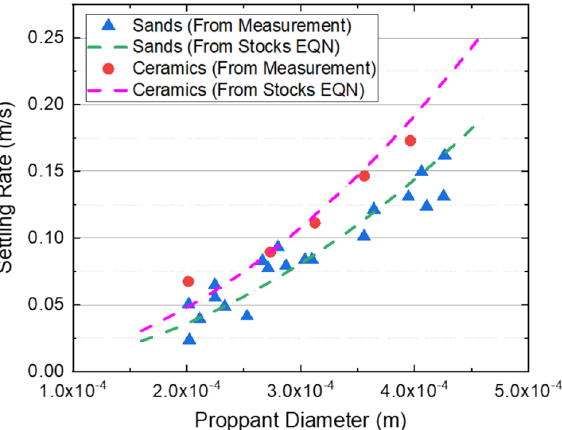
Figure 7. Measured and calculated settling rates of ceramic proppants and silica sands at different diameters.